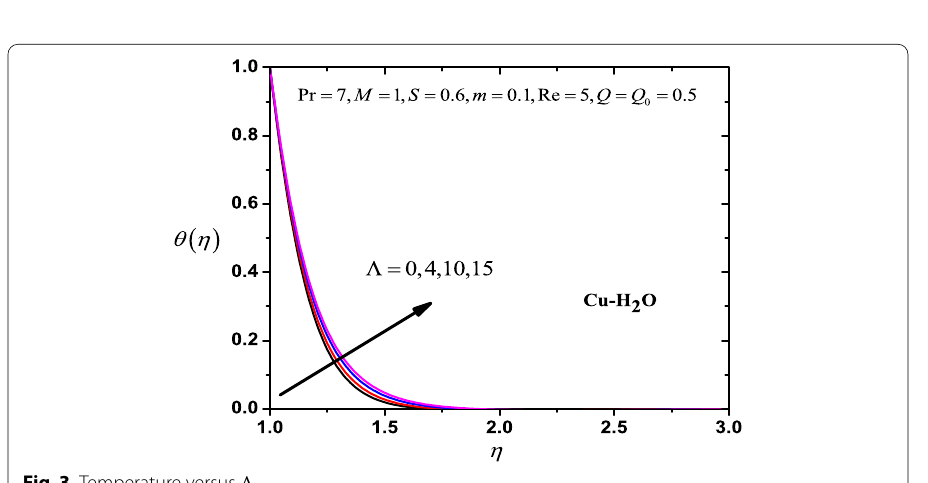
Fig. 3 Temperature versus